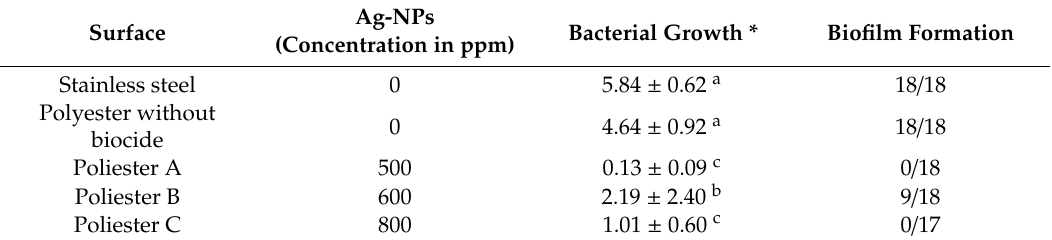
Biofilm Formation